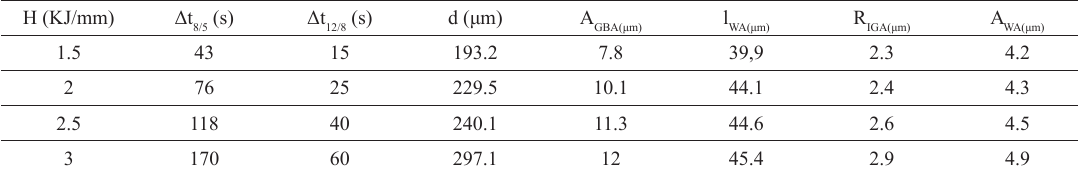
Table 5. Microstructural parameters of the simulated HAZs corresponding to the UNS S32304 DSS at different cooling times. Average grain size of ferrite (d), average width of the GBA (A and average width of the WA laths (A